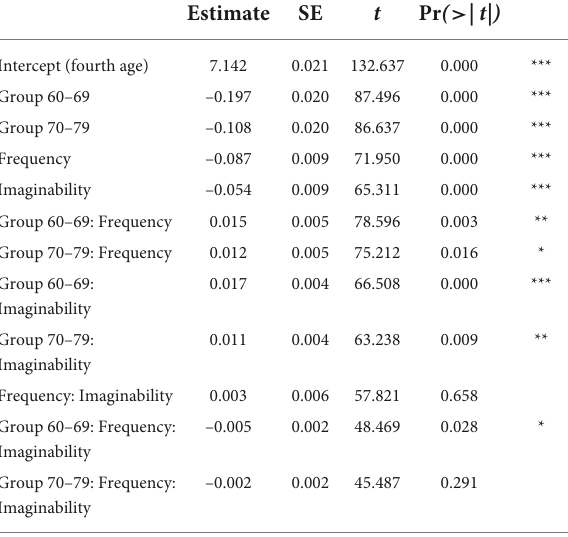
TABLE 5 Linear mixed-effects regression reaction time results for Experiment 3.